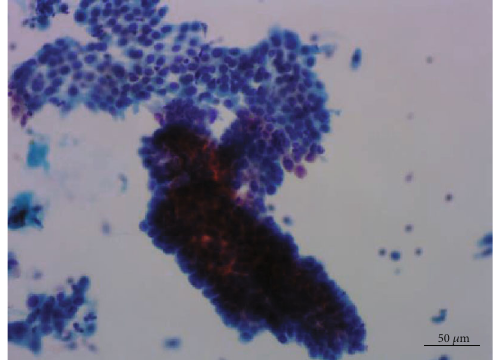
Figure 5: Thinprep Cytologic Test of papillary adenoma demonstrated papillary clusters. Pap staining, × 200.